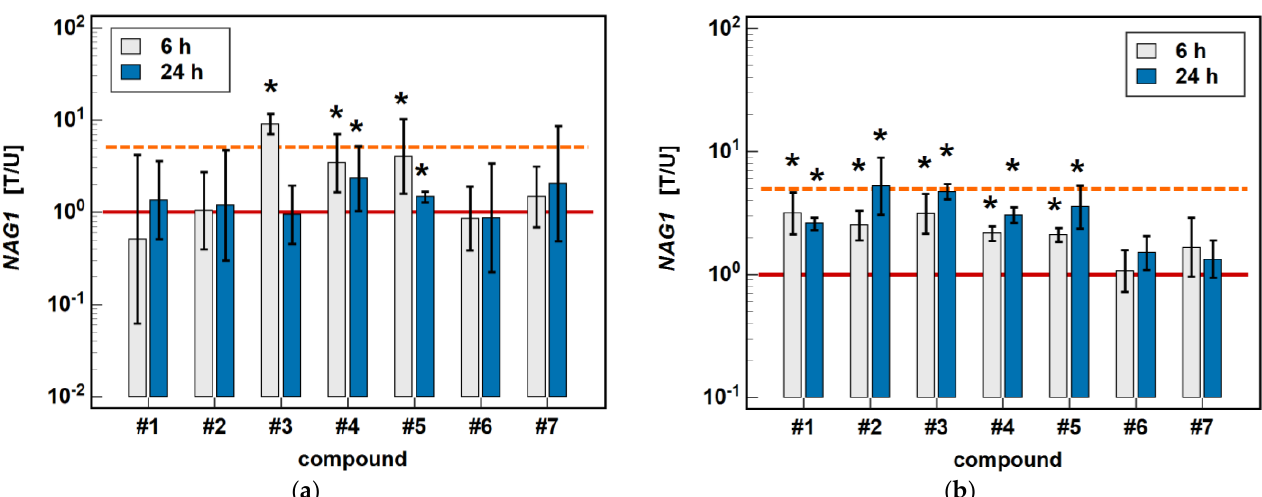
Figure 9. Time-dependent effect of oxicams on NAG1 expression in ( a ) Caco-2 cells and ( b ) hCT 116 cells. The bars and whiskers represent the mean ± SD expression ratio of the normalized relative quantities [NRQ] obtained for cells treated with 200 µ M oxicams for 6 and 24 h, and the corresponding untreated controls [T/U]. The significant differences between the treated and untreated cells, analyzed using a t -test for paired samples, are indicated by asterisks (*). An expression ratio of 1 (no change) is indicated by a red solid reference line, while an expression ratio of 5 (5-fold upregulation) and an expression ratio of 0.2 (5-fold downregulation) are indicated by an orange dashed reference line. Compound # 6 denotes piroxicam, and # 7 denotes meloxicam.